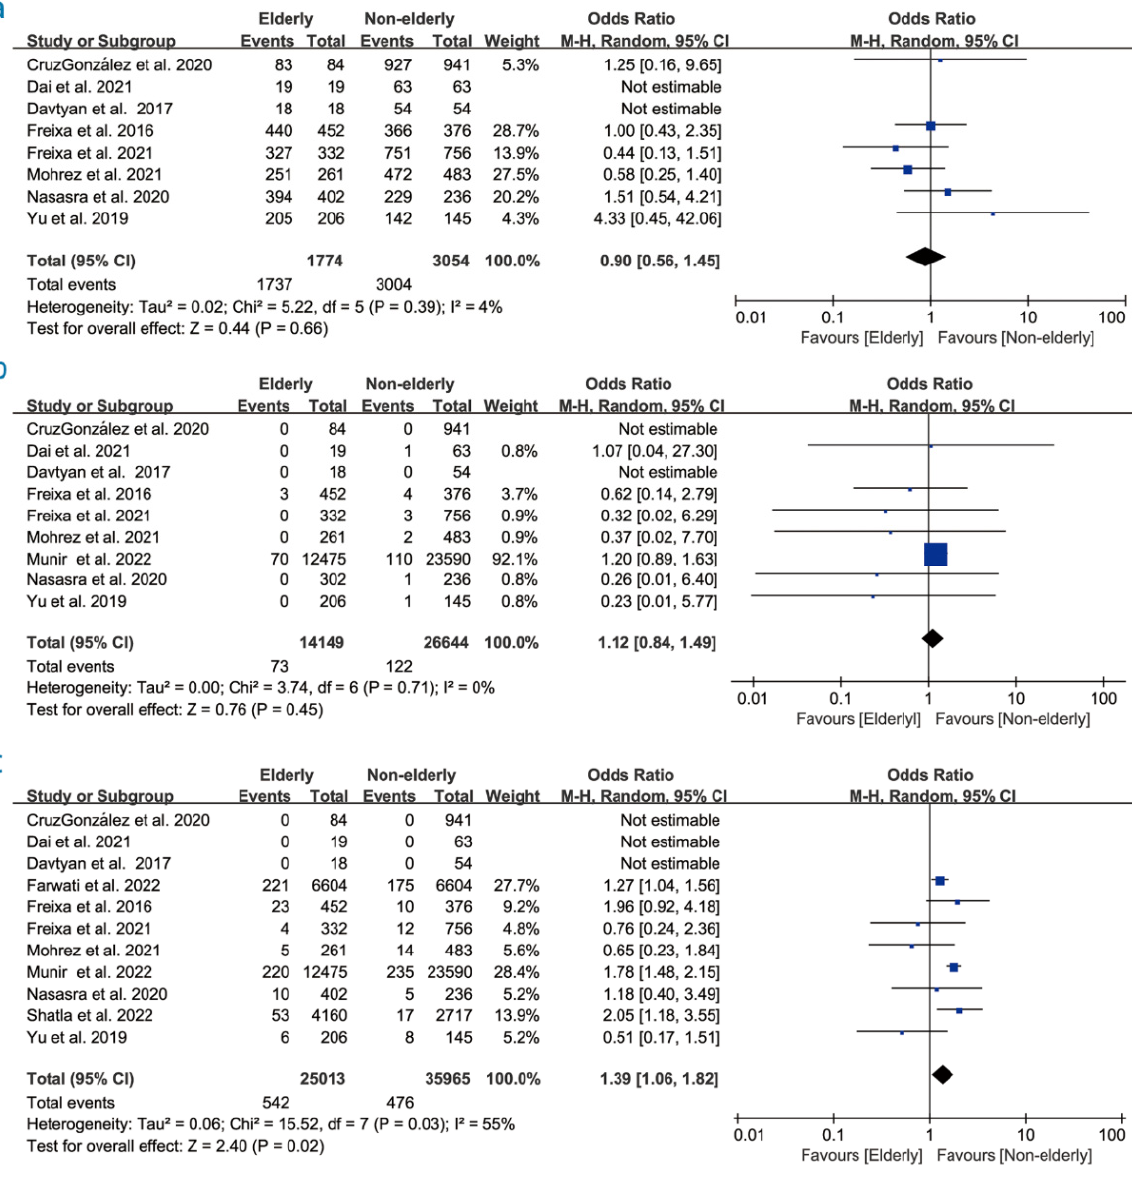
Figure 2. Forest plot showing the effect of left atrial appendage closure on ( a ) successful implantation LAAC rates, ( b ) stroke, and ( c ) pericardial effusion/tamponade [14–17,20–27].